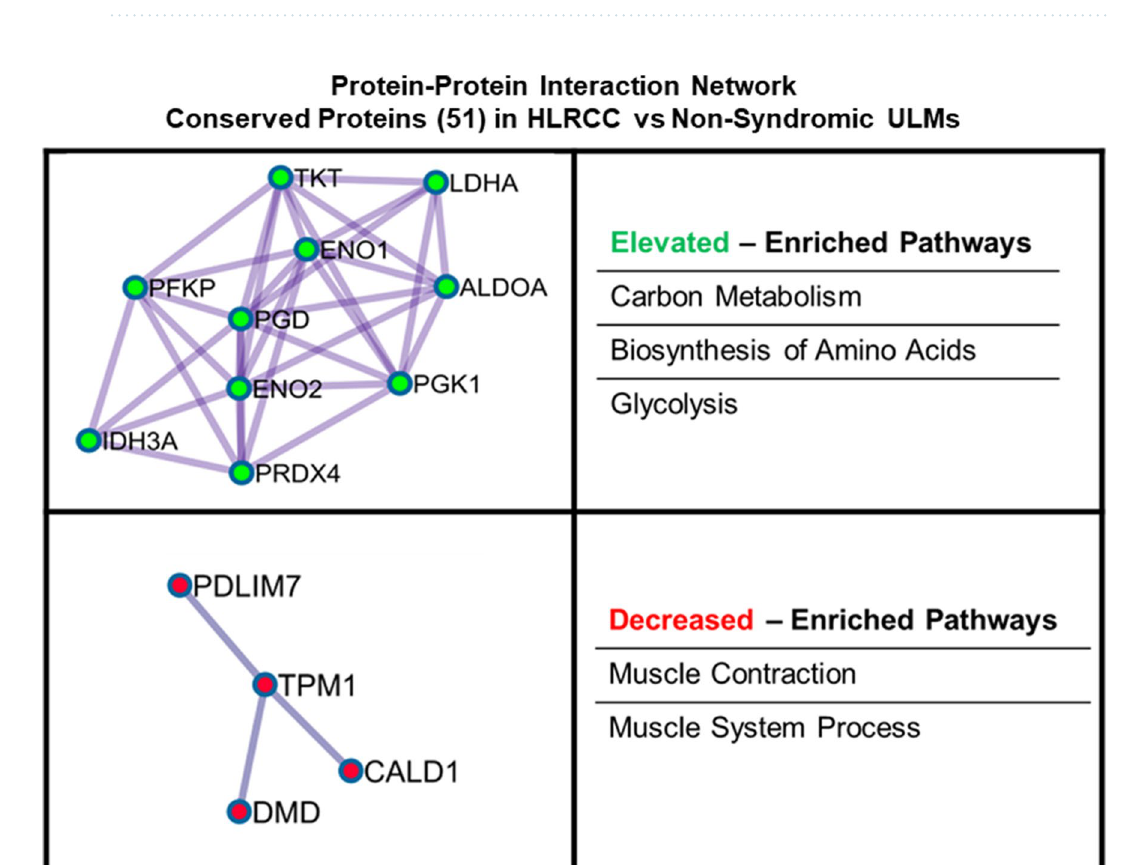
Table 3. Conserved protein and transcript alterations in HLRCC versus Non-Syndromic (NS) ULMs that are putative drug targets. Table denotes top elevated or decreased alterations in HLRCC vs NS ULMs that are putative drug targets (Ingenuity pathway analyses).